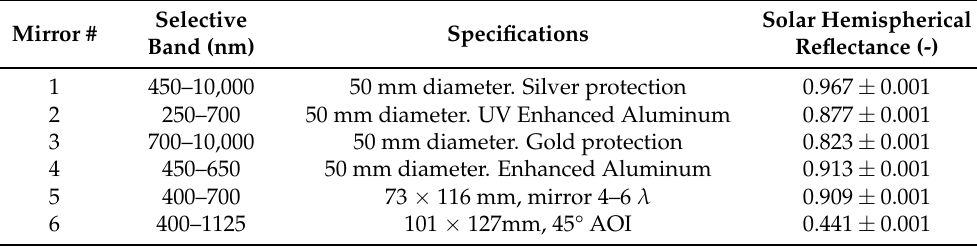
Table 3. Set of mirror for wavelength filtering of concentrated solar radiation in the solar furnace.